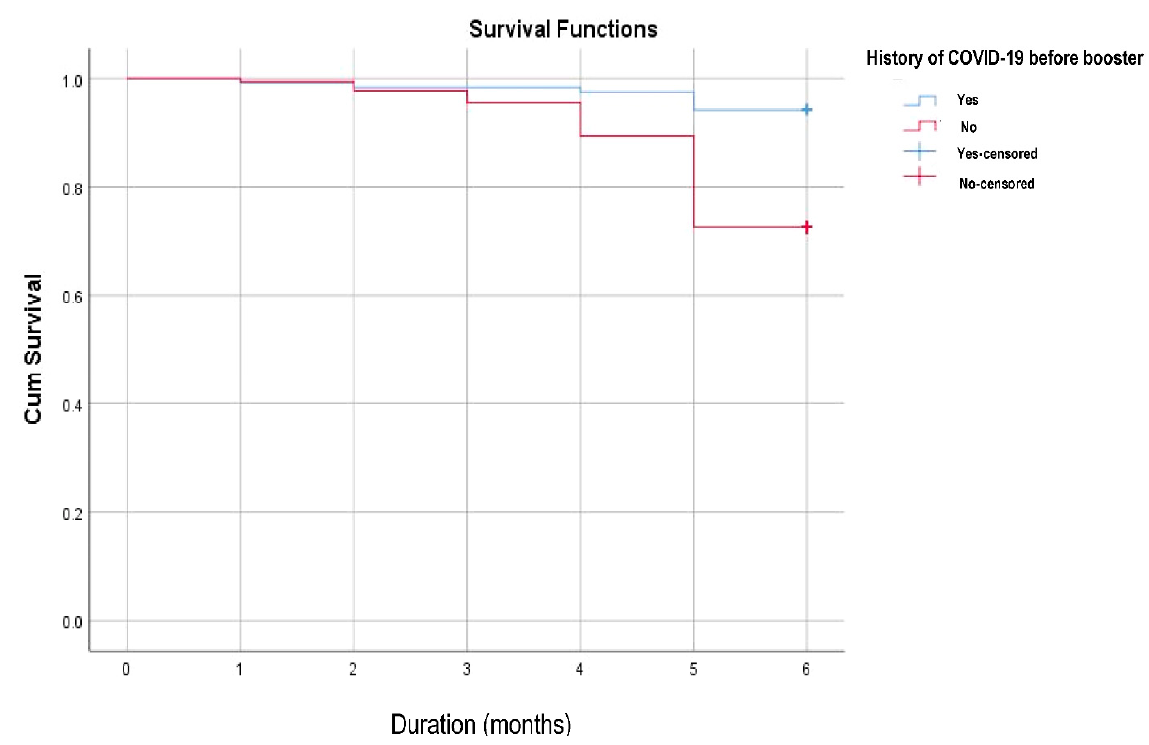
Figure 5. Kaplan–Meier analysis of COVID-19 incidence among participants with a history of COVID-19 and participants without a history of COVID-19 (n = 300). This figure displays the difference in confirmed SARS-CoV-2 infections after booster vaccination among subjects with history of COVID-19 before the booster (n = 121) and those without a history of COVID-19 before the booster (n = 179). The median sRBD antibody level of the 300 participants was 659 BAU/mL (min 37 BAU/mL, max 5680 BAU/mL, QIR 822 BAU/mL). The median duration of